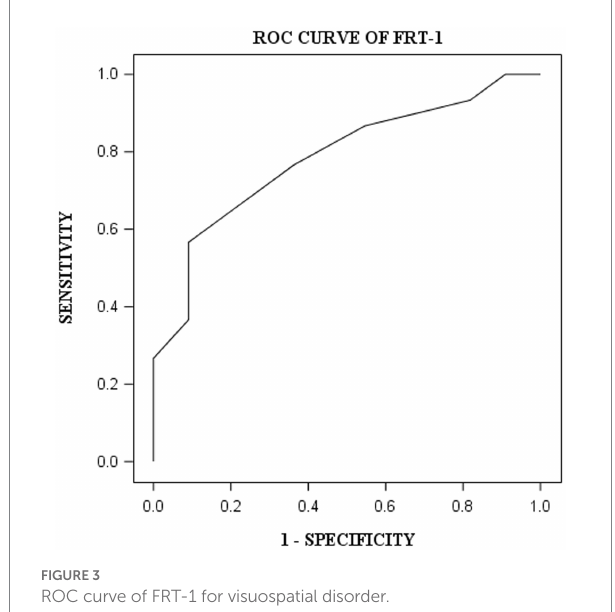
FIGURE 3 ROC curve of FRT-1 for visuospatial